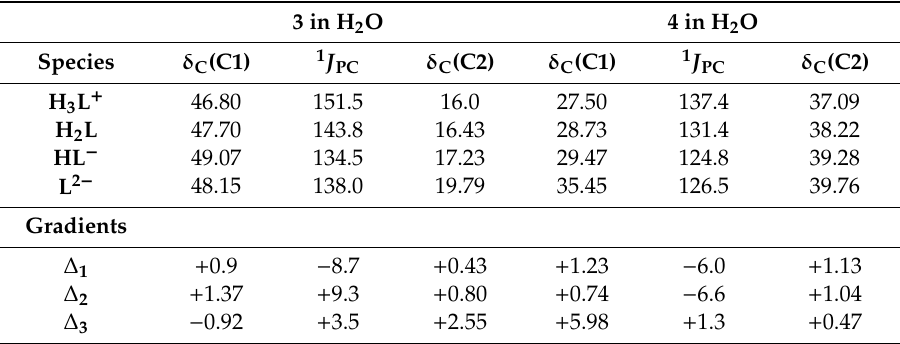
Table 8. Specific chemical shifts δ C [ppm], coupling constants 1 J PC [Hz], and corresponding gradients ∆ for α -aminoethanephosphonic acid ( α -Ala-P) 3 and β -aminoethanephosphonic acid ( β -Ala-P, CILIATIN) 4 . Spin enumerations: 3 : C2-C1(N)-P; 4 : (N)C2-C1-P. 1 J PC shows a minimum for species HL − of 3 and 4 . 2 J PC was not resolved for compounds 3 and 4